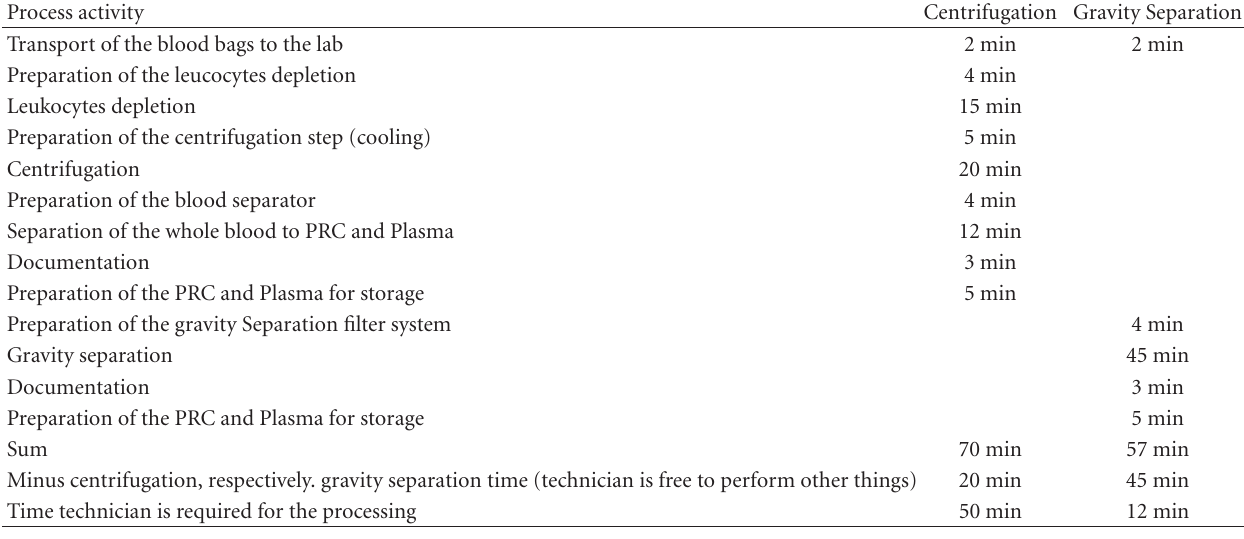
Table 8: Comparison of the mean processing times of the classical separation method and gravity